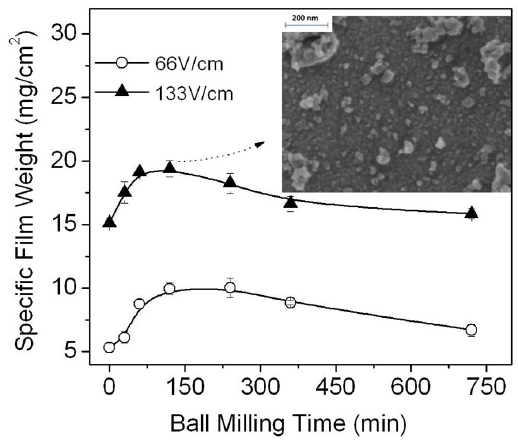
Figure 3. Specific deposited weight as a function of the ball milling time (deagglomeration) for two different electric fields applied(thick films deposited with EtOH+Acac suspension, nanoparticles concentration of 5 mg/cm 3 and deposition time of 120s). The insert presents a SEM micrograph of the BTZ powders deagglomerated for 2